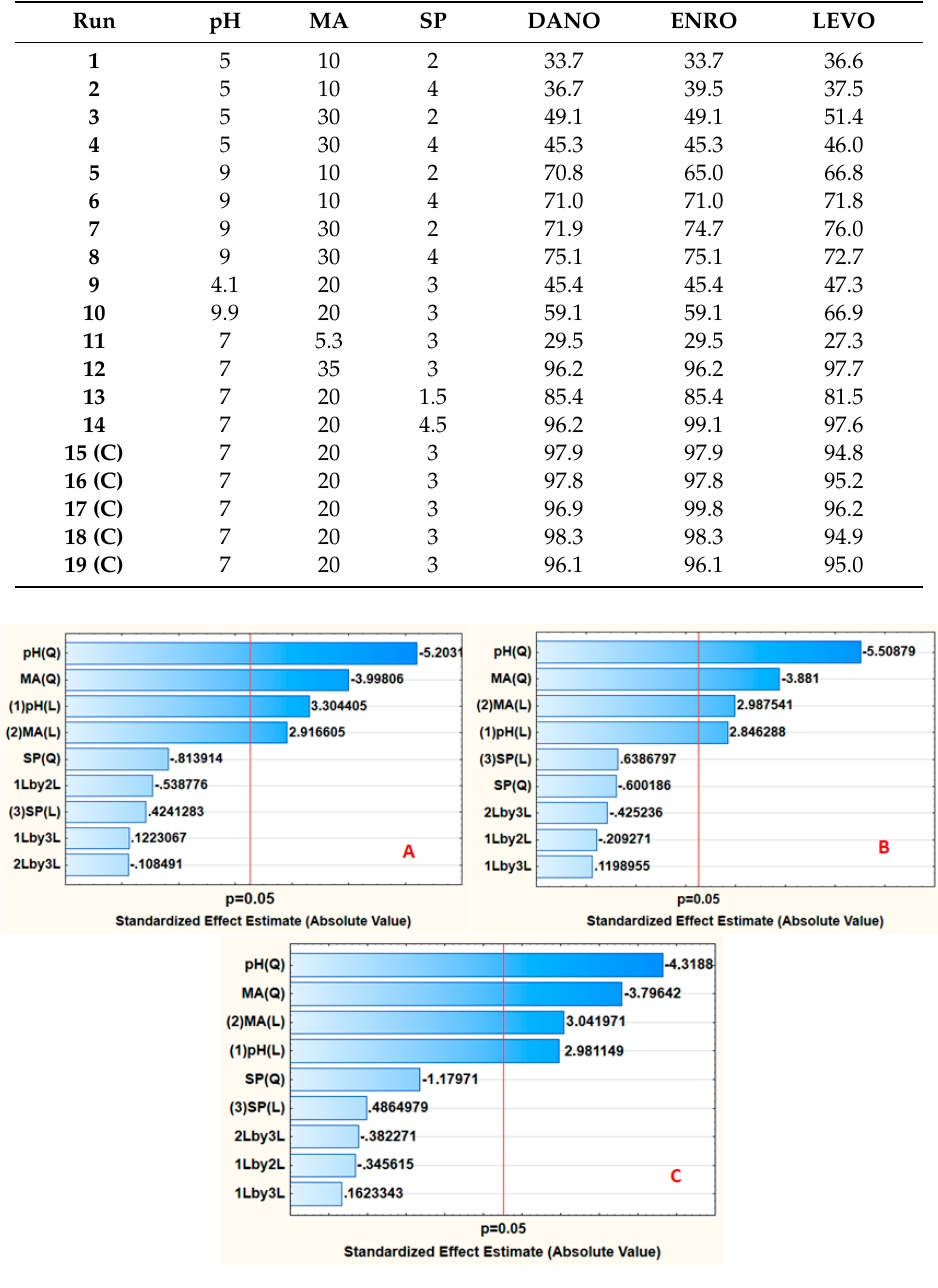
Figure 4. Pareto chart of standardized e ff ects for adsorption of ( A ) DANO, ( B ) ENRO and ( C ) LEVO). MA = mass of adsorbent; SP = sonication power; 1Lby2L shows the interaction between pH and MA; 2Lby3L shows the interaction between MA and SP; 1Lby3L shows the interaction between pH and